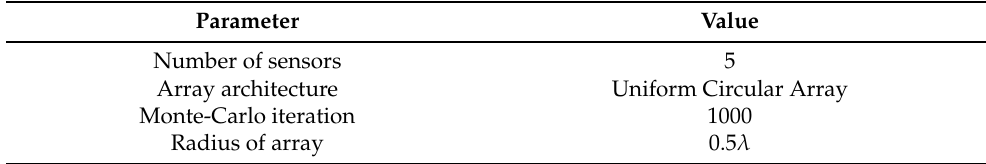
Table 1. Simulation condition. Parameter Value Number of sensors 5 Array architecture Uniform Circular Array Monte-Carlo iteration 1000 Radius of